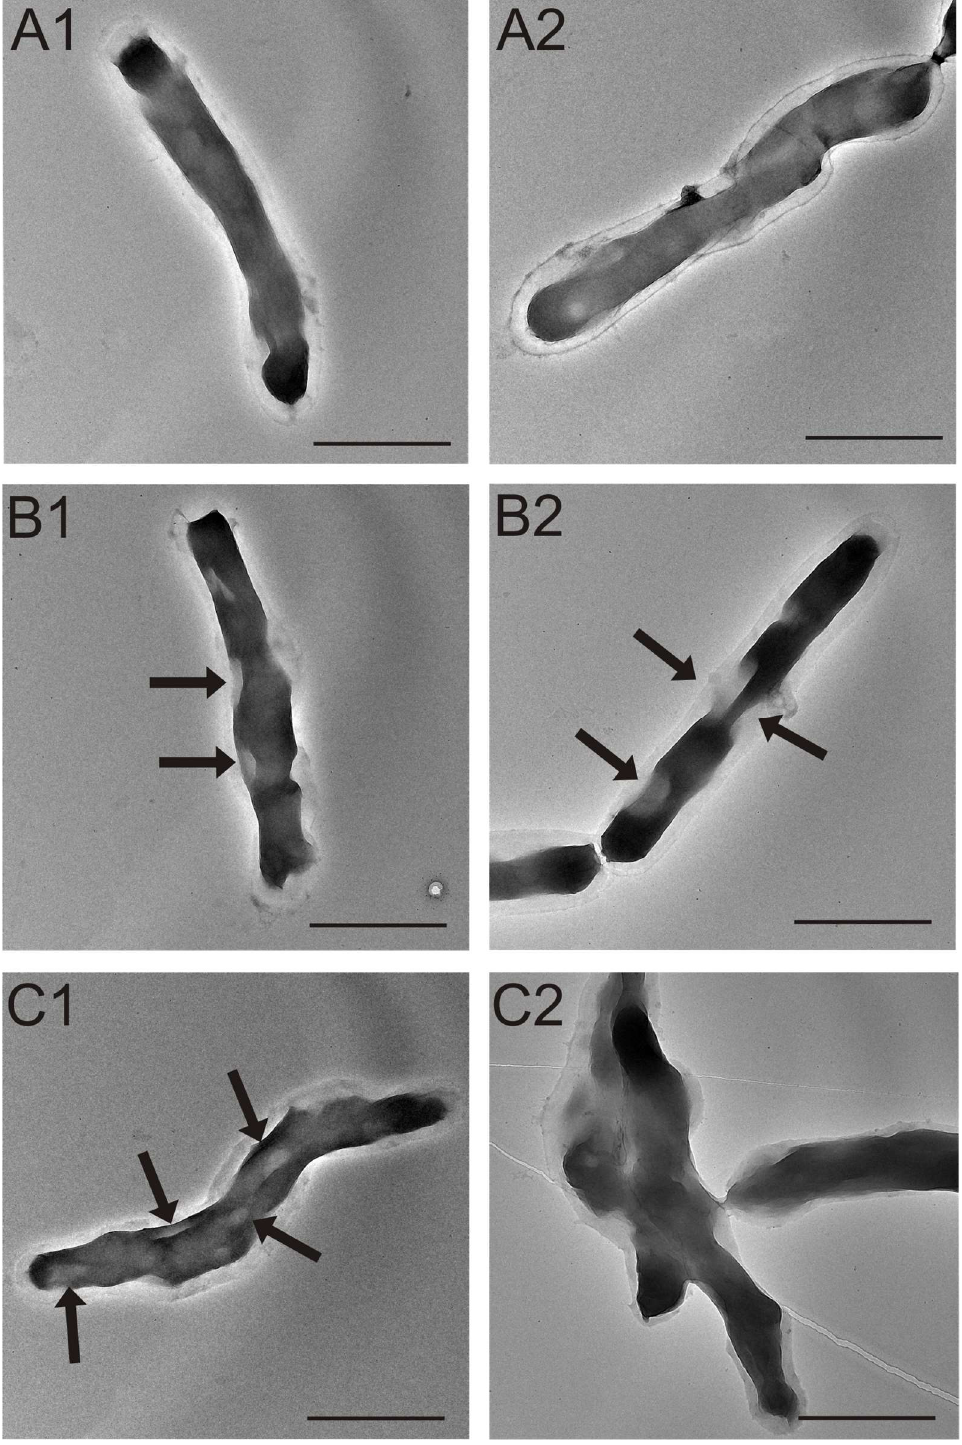
Figure 7. Transmission electron microscopy images of M. smegmatis cells: ( A1 , A2 )—control M. smegmatis cells; ( B1 – C2 )—cells treated with the S. hermaphrodita protein seed extract at a concentration of 150 µ g/mL. Arrows indicate defects in mycobacterial cell wall continuity induced by the treatment with the extract. The scale bar corresponds to 2 µ